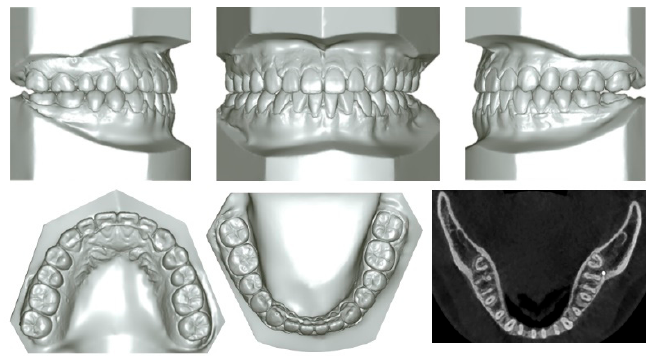
Figure 10. Posttreatment dental casts and CBCT axial image of the mandible. Figure 10. Pos tt reatment dental casts and CBCT axial image of the mandible. Figure 10. Pos tt reatment dental casts and CBCT axial image of the mandible. Figure 10. Pos tt reatment dental casts and CBCT axial image of the mandible.